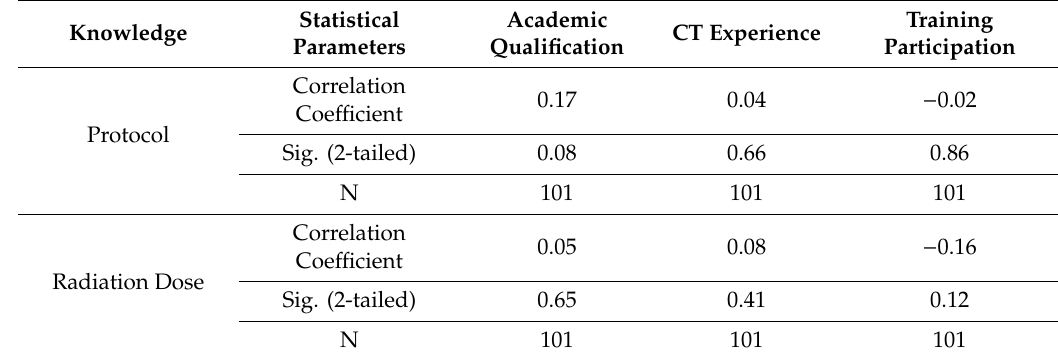
Table 6. Correlation matrices between knowledge score and qualification, experience, and training.